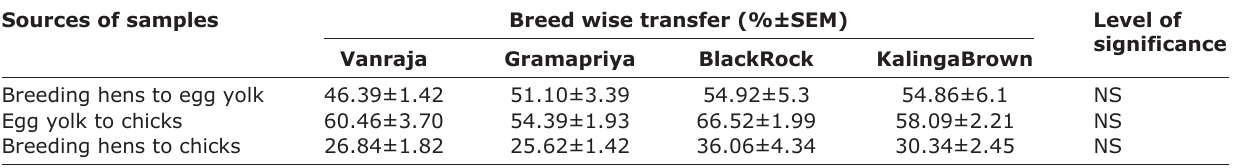
Table-4: Percentage transfer of IgY from breeding hens to egg yolk and chicks in four different breeds of poultry. Sources of